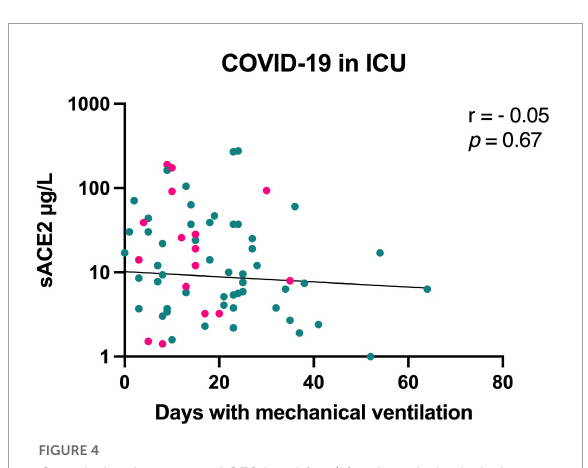
FIGURE4 Correlation between sACE2 level ( µ g/L) at hospital admission and days with mechanical ventilation for patients with COVID-19 in the intensive care unit (ICU). Men = green, women = pink.